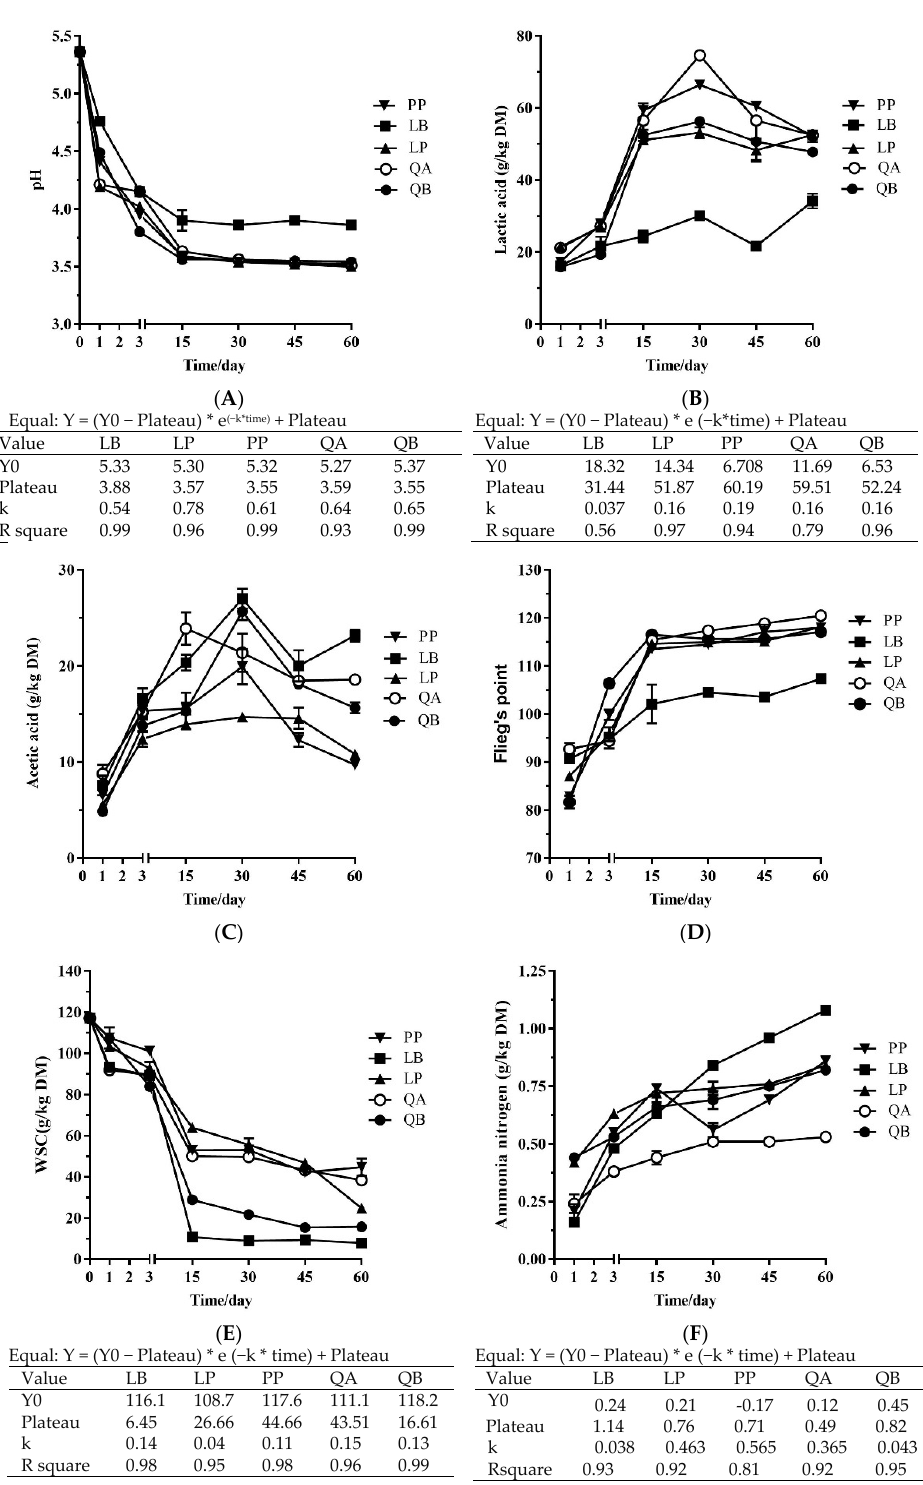
Figure 1. Effects of additives and ensiling time on pH ( A ), the concentrations of lactic acid ( B ), acetic acid ( C ), Flieg’s point ( D ), water soluble carbohydrates ( E ) and ammonia nitrogen ( F ) of whole corn silages during